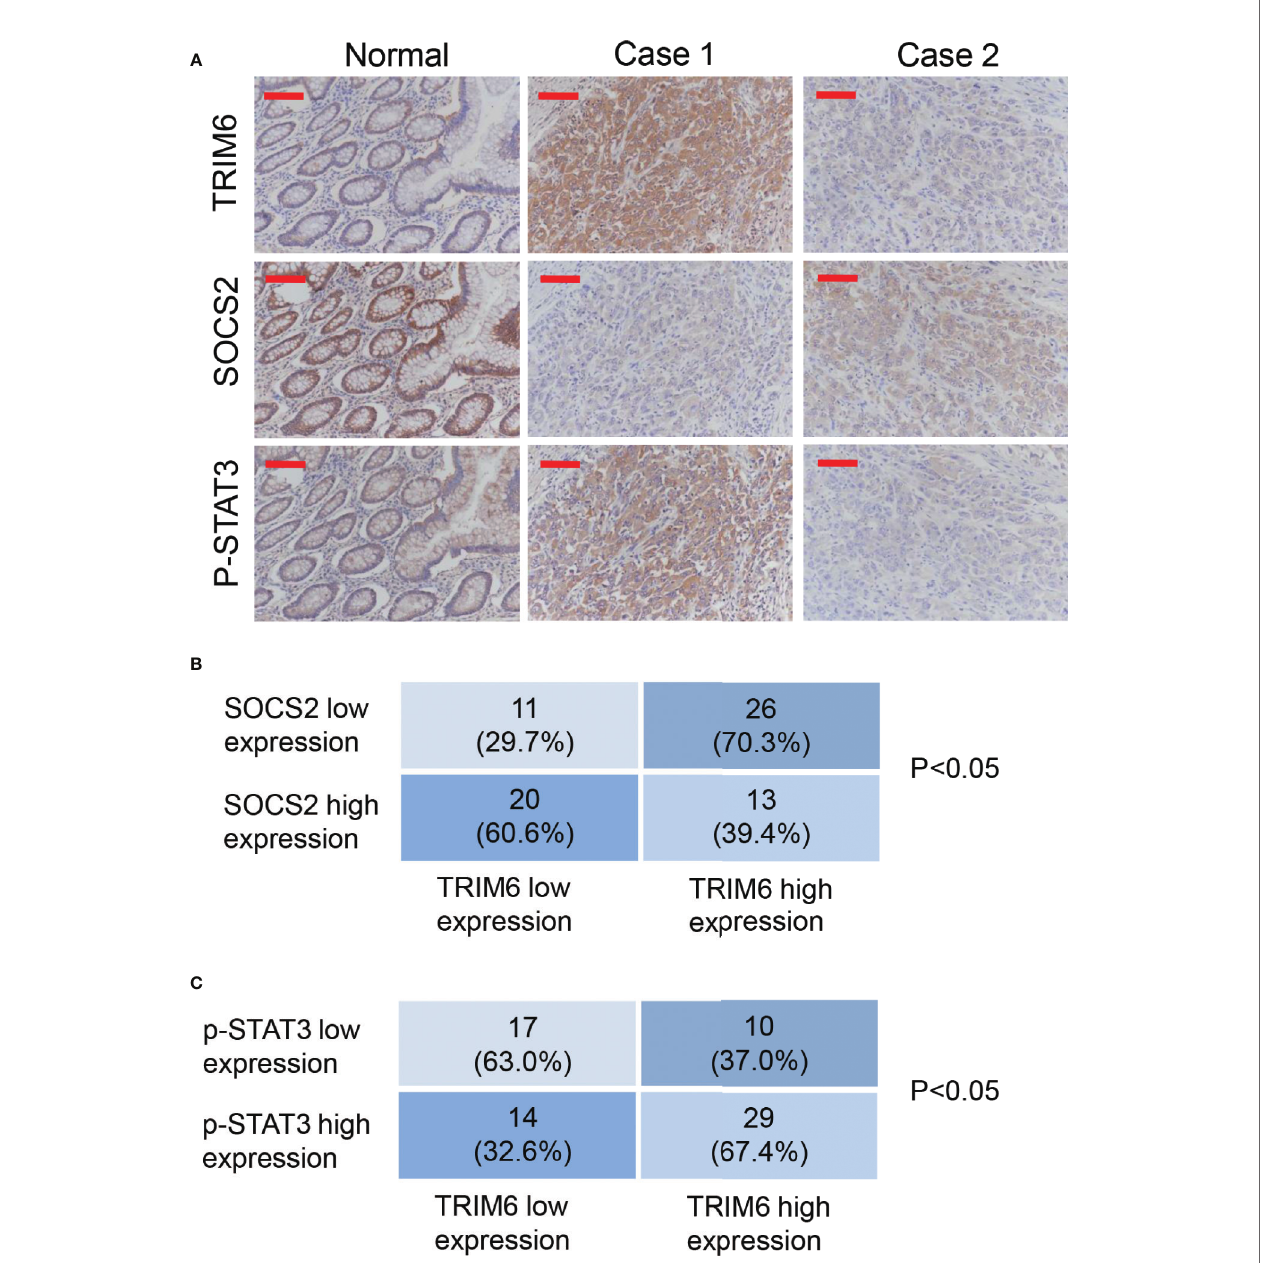
FIGURE 5 | TRIM6 expression positively correlated with p-STAT3 and negatively correlated with SOCS2 in the CRC samples. (A) Representative immunohistochemical staining of TRIM6, SOCS2, and p-STAT3 in paraf fi n-embedded normal and CRC specimens (Case 1 and Case 2). n = 70. Scale bar: 100 µm. (B, C) Statistical analysis of CRC tissues under different staining